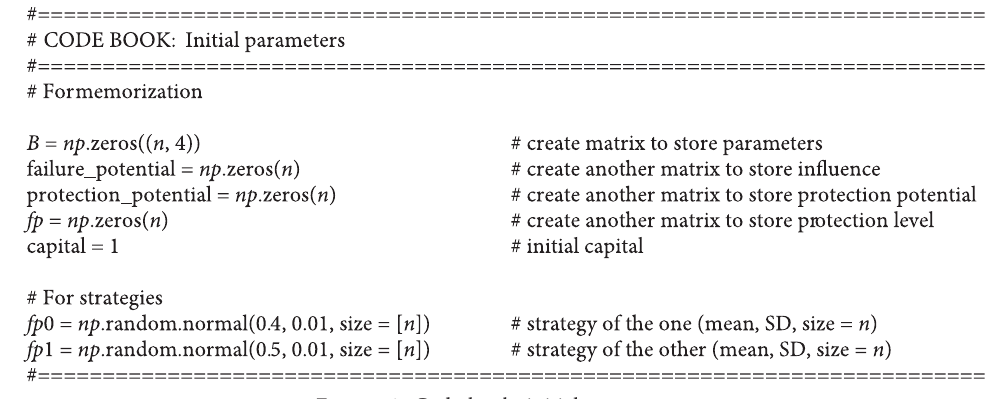
Figure 9: Code book: initial